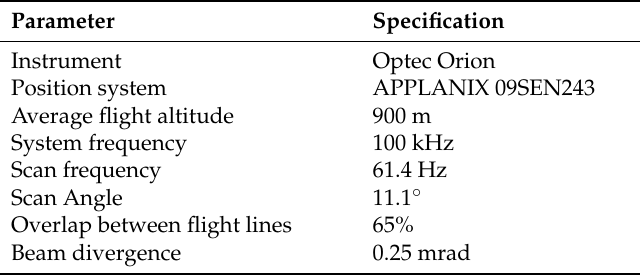
Table 1. Laser system parameters for LiDAR data